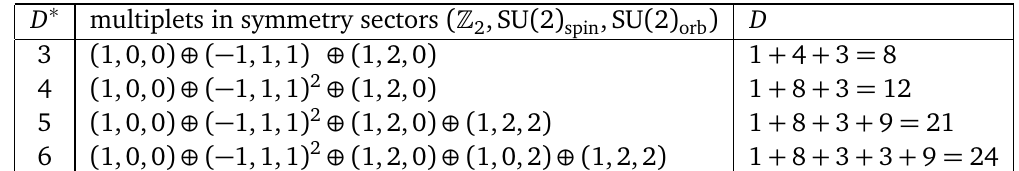
Table 1: Typical multiplet configurations on the auxiliary bonds obtained from sym- metric iPEPS simulations on the square lattice with two symmetric spinful orbitals. The rows show the results for varying multiplet bond dimension D ∗ (left column) at half filling. The corresponding state space dimension D is listed in the right column. In the multiplet listing on the left, the notation ( · ) m indicates m multiplets in the sym- metry sector ( · ) , with m = 1 if not specified. For better readability, we also adopt the QSpace [ 30 ] convention of specifying SU ( 2 ) multiplets through the integer number 2 S (i.e., the number of boxes in the corresponding Young